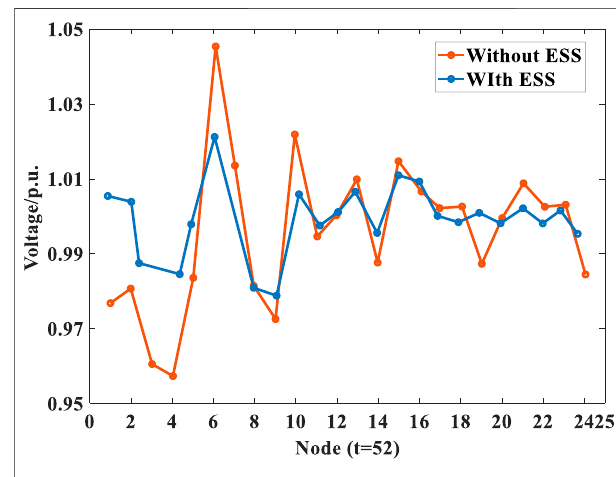
FIGURE 16 | The voltage profile (p.u.) of the network without or with the ESS operation during UHV transmission failures (time step 52).